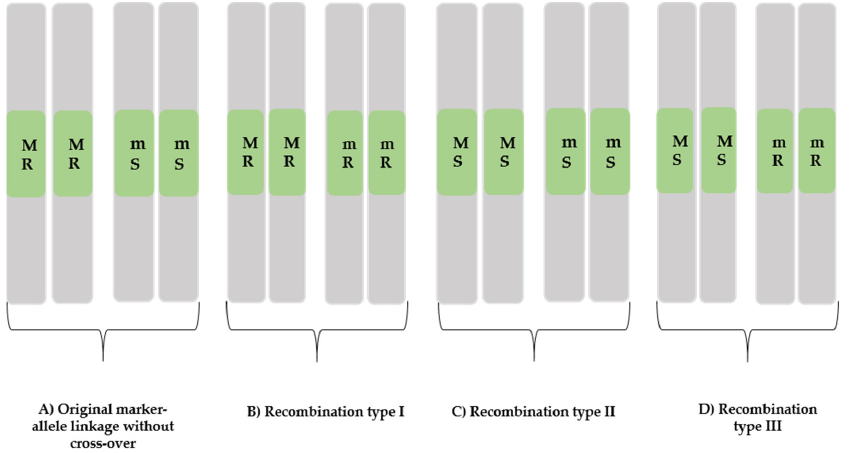
Figure 3. Four types of outcomes were observed in the heterogeneous inbred lines during near- isogenic line (NIL) development, when non-recombination or recombination occurred. The above- mentioned NIL pairs were obtained from selfing F 7 heterozygous lines derived from F 2 single-seed descent progenies. R in green boxes indicates the gene allele responsible for metribuzin resistance, and S in green boxes indicates the gene allele for metribuzin susceptibility. M in green boxes represents the resistant molecular marker from the resistant parent Chuan Mai 25, and m in green boxes represents the susceptible molecular marker from the susceptible parent Ritchie. ( A ) Marker–allele linkage type. ( B – D ) Recombination types.